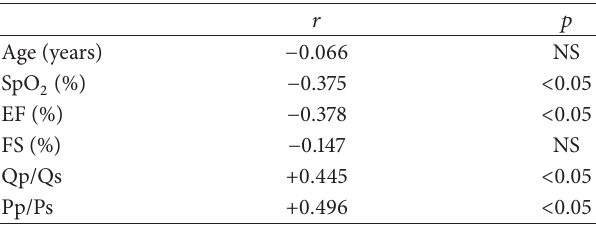
Table 5: Univariate analysis of risk factors of myocardial injury in patients.